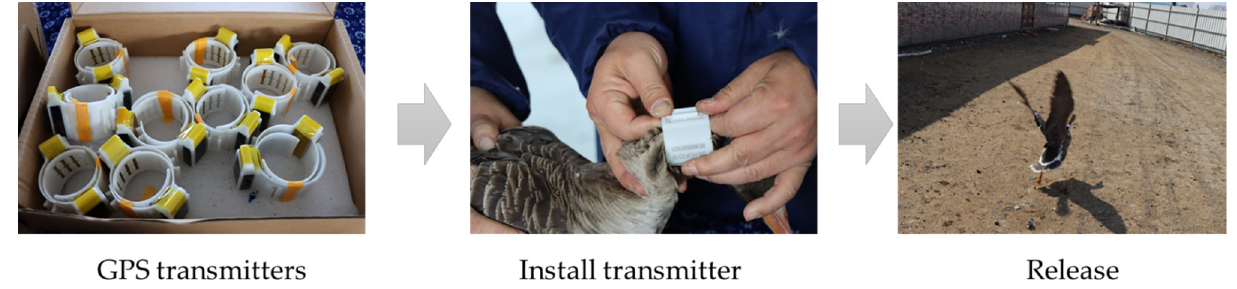
Figure 2. GPS transmitters installation process.